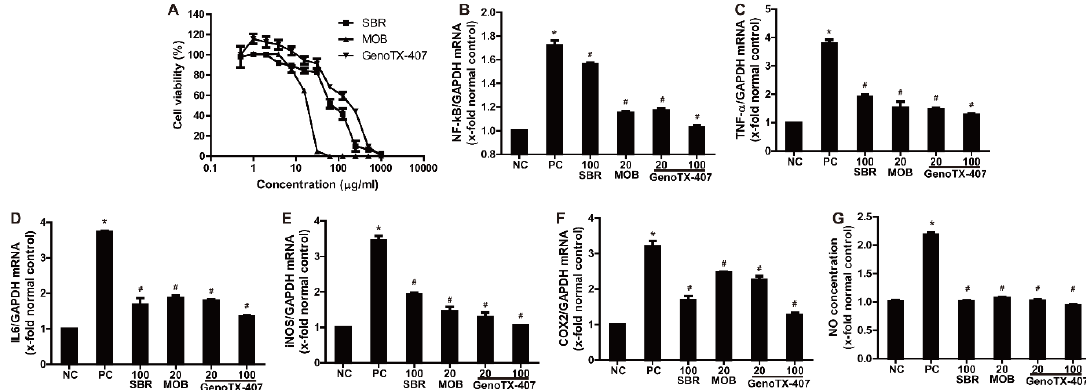
Figure 2. Anti-inflammatory activities of SBR, MOB, and GenoTX-407. ( A ) Cell viability in response to SBR, MOB, and GenoTX407 in the MTT assay. ( B – F ) Real-time PCR for checking the mRNA expression of NF- κ B ( B ), TNF- α ( C ), IL-6 ( D ), iNOS ( E ), and COX2 ( F ), normalized to GAPDH . ( G ) Inhibitory e ff ect on LPS-induced NO generation. *Significantly di ff erent from normal controls ( p < 0.05). # Significantly di ff erent from positive controls ( p < 0.05). SBR, Scutellaria baicalensis root; MOB, Magnolia o ffi cinalis barks; GenoTX-407, combination of SBR and MOB; LPS, lipopolysaccharide.